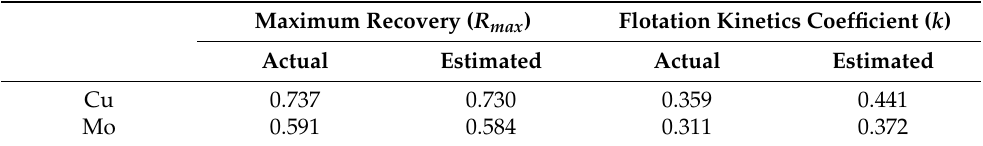
Table 10. Comparison of actual and estimated value on maximum recovery ( R max ) and flotation kinetics coefficient ( k ).